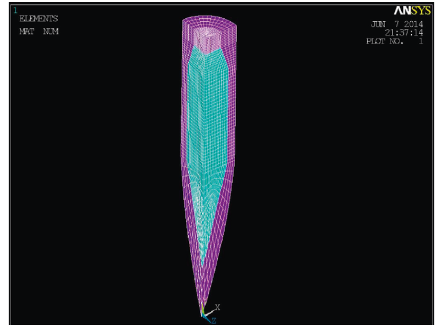
Figure 3: 0.30 ″ AP model.